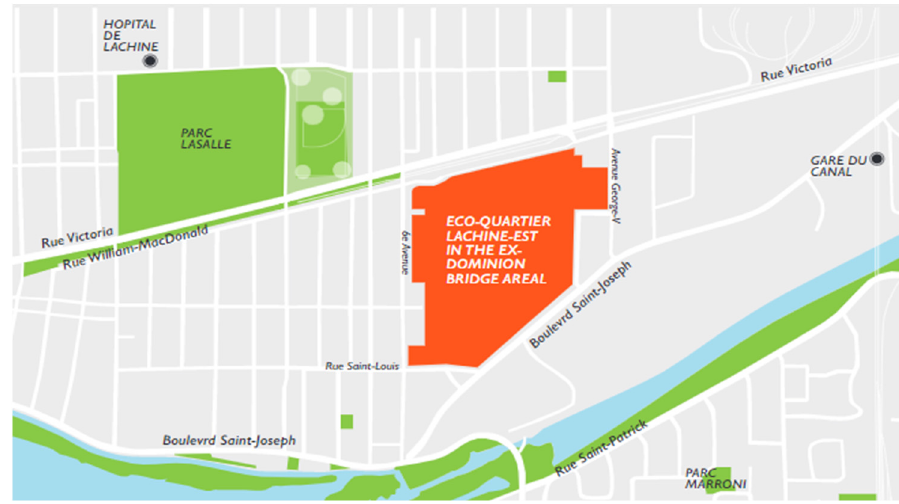
Figure 2. Location of the considered eco-district case study in Lachine East, Montreal, Canada.